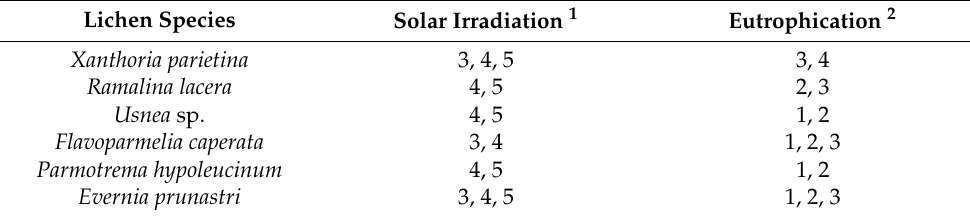
1 Values mean: 1 in very shaded situations, 2 in shaded situations, 3 in sites with plenty of diffuse light but scarce direct solar irradiation, 4 in sun-exposed sites, 5 in sites with very high direct solar irradiation. 2 Values mean: 1 no eutrophication, 2 very weak eutrophication, 3 weak eutrophication, 4 rather high eutrophication, 5 very high